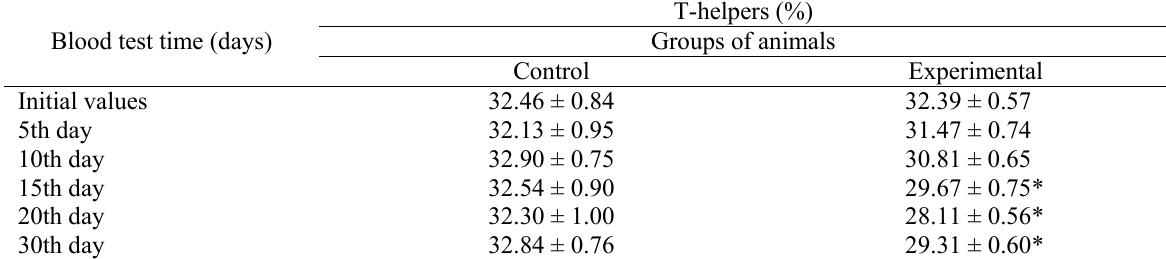
The number of T-helpers in the blood of bulls under the influence of chronic cadmium toxicosis (М ± m, n = 5)